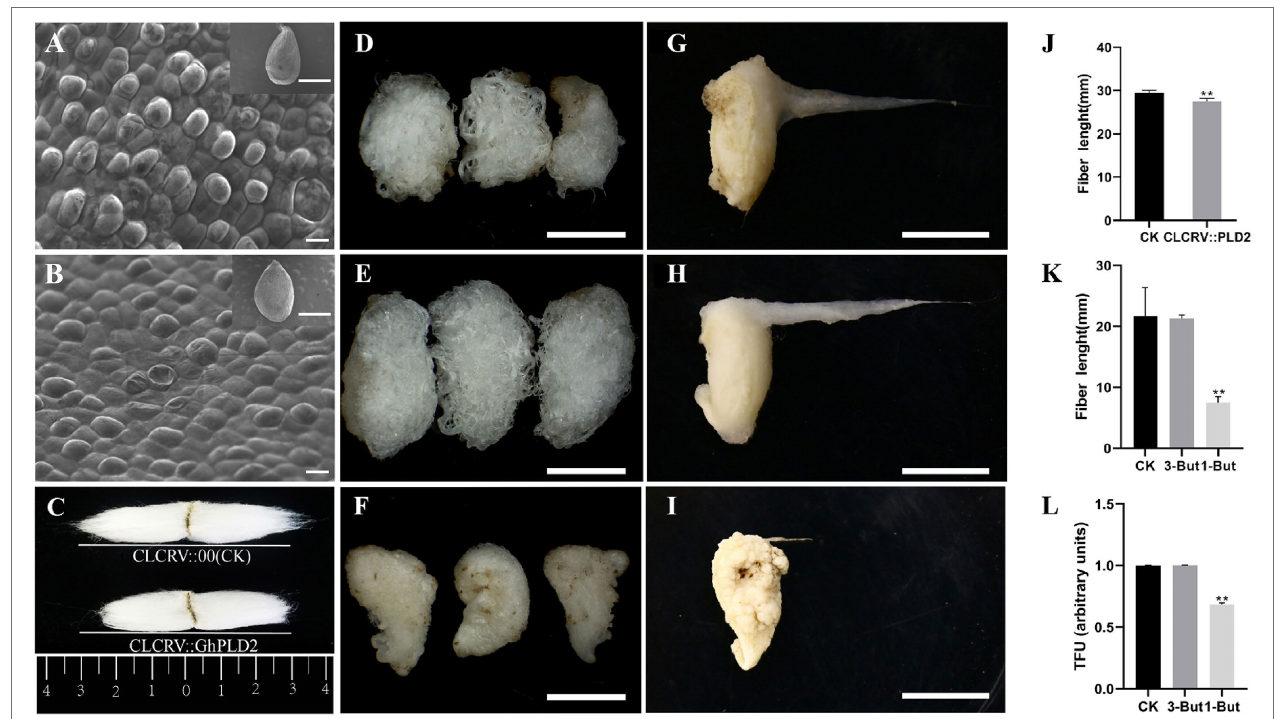
FIGURE 5 | Inhibition of PLD activity affects fiber elongation, and GhPLD2 is involved in fiber initiation and elongation. (A–C) Silencing GhPLD2 inhibited fiber initiation ( A , ovule of blank control, B , ovule of VIGS plant) and significantly reduced fiber length (C,J) scale bar = 1 mm, scale bar = 10 μ m. (D–I) Seed and fiber morphological characteristics in the in vitro culture after treatment with 1-But (F,I) , 3-But (E,H) , and sterile water (CK; D,G ); scale bar = 1 cm. (K) Fiber length in 1-But and 3-But treated cultures. (L) Total fiber units (TFUs) in 1-But and 3-But treated cultures. Error bars show the standard deviation estimated using three independent experimental repeats. Statistical analyses of experimental data were performed using t -tests. Asterisks show that the values of p indicate very significant (** p < 0.01) differences as compared to the